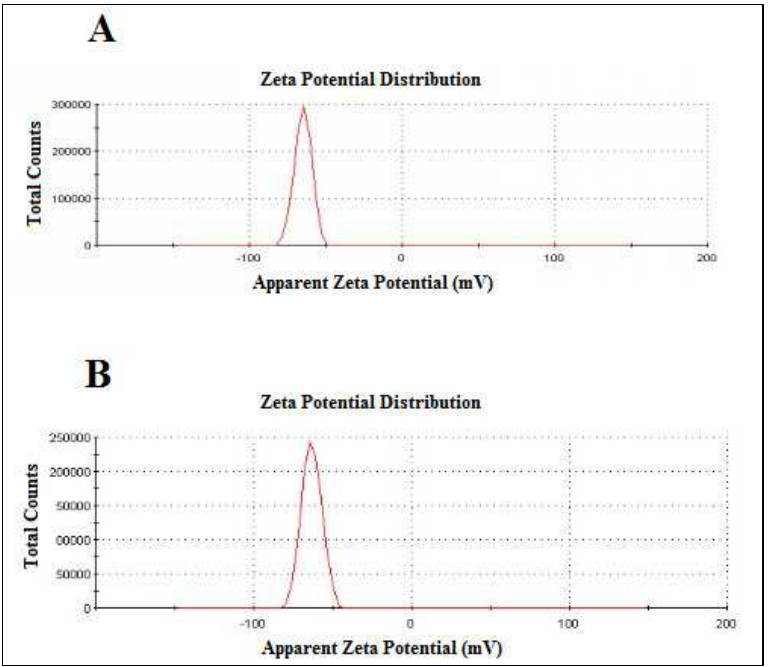
Figure 6. Zeta potential data: ( A ) tamoxifen citrate loaded nanolipid vesicles; ( B ) antibody conjugated tamoxifen citrate loaded nano lipid vesicles. Table 2. Zeta potential, poly dispersity index (PDI), mobility and conductivity of nanolipid vesicles. Formulations